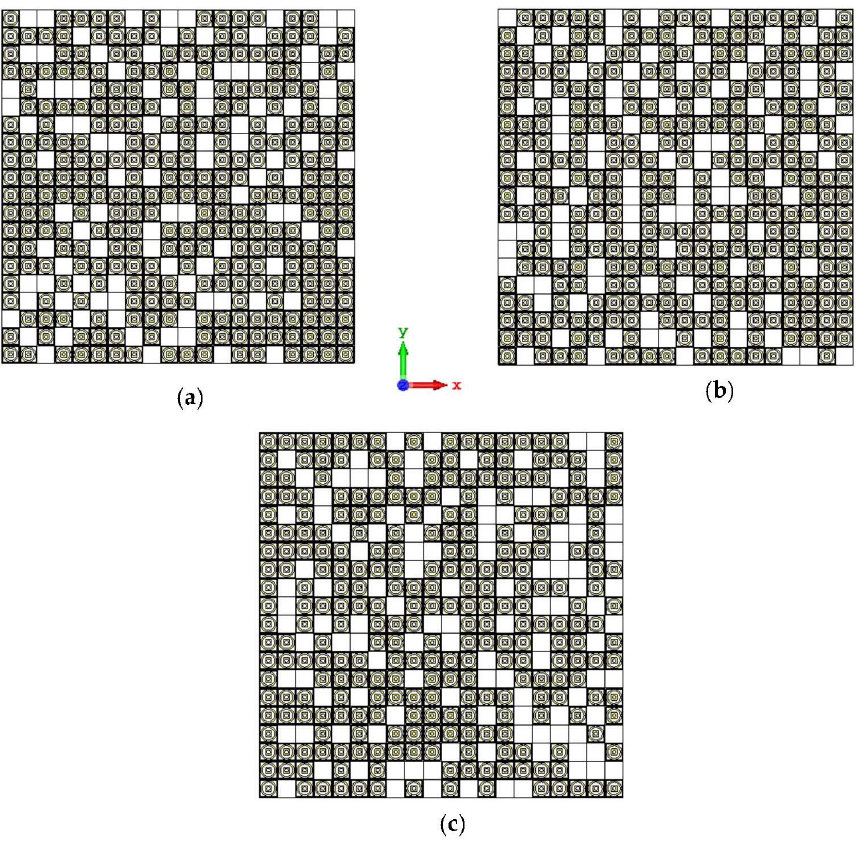
Figure 10. Coding metamaterial designs for 20 lattices: ( a ) Coding Sequence 1; ( b ) Coding Sequence 2; and ( c ) Coding Sequence 3.